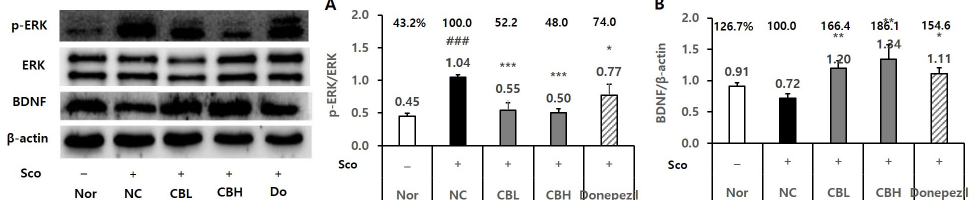
Figure 4. Effects of CB extract on the expression of ( A ) hippocampal p-ERK/ERK, and ( B ) BDNF of chronically Sco-treated rats. Rats were randomly divided into five groups. Nor, normal, commercial diet + saline; NC, negative control (Sco), commercial diet + Sco in saline; CBL, CB extract 0.07% diet + Sco in saline; CBH, CB extract 0.14% diet + Sco in saline; Donepezil; commercial diet + 1 mg/kg Donepezil in saline + Sco in saline (n = 3 for p-ERK/ERk and BDNF). Sco at 1 mg/kg was administered to rats one time per day for 21 days (i.p). Significance was determined by one-way ANOVA with post hoc Tukey’s multiple comparison test. Data are presented as means ± standard errors of the mean (SEM). ### p < 0.001 significance compared with the control (white bar). * p < 0.05, ** p < 0.01, *** p < 0.001 significance compared with A β -treated groups (black